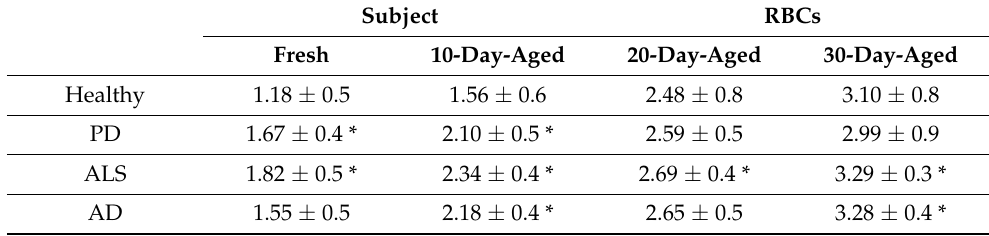
Table 2. Young’s modulus (MPa) determined for fresh and aged healthy and NDDs RBCs, mean values ± SD.